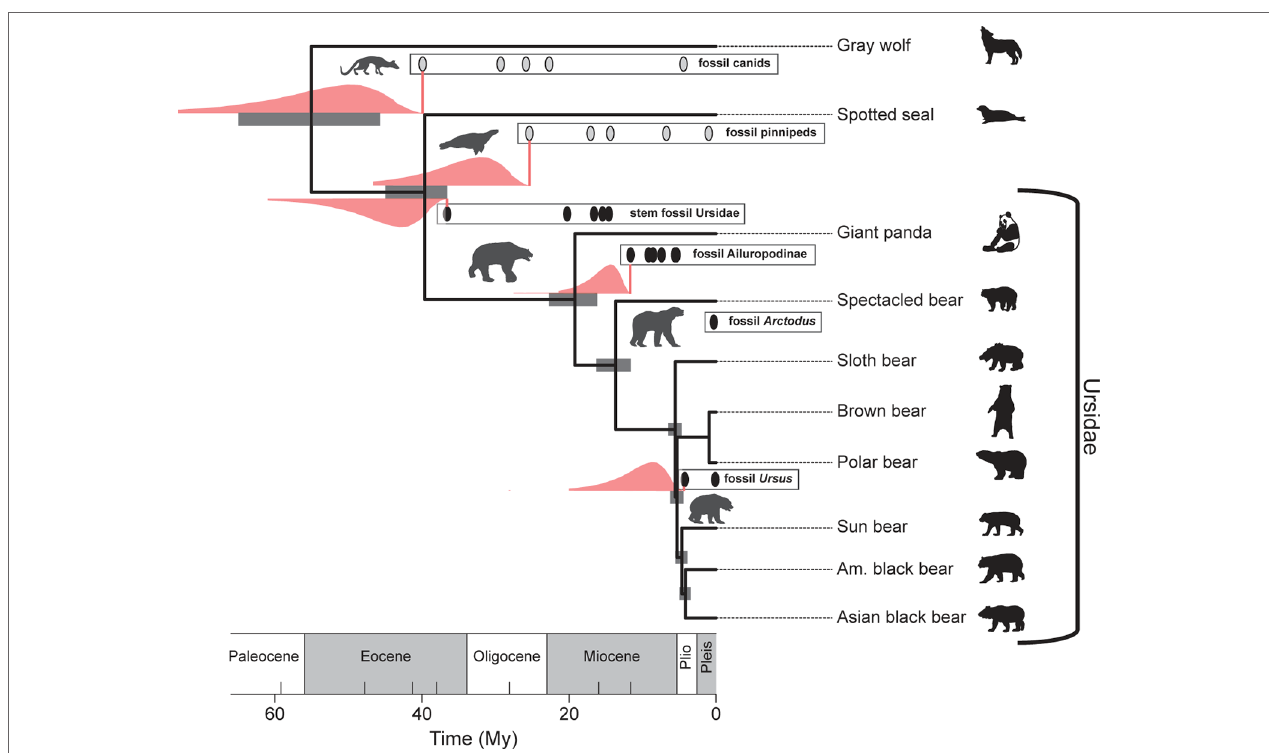
FIGURE 5 | Broad agreement in the estimated uncertainties in the divergence times of selected bear and outgroup lineages based on the FBD (fossilized birth– death) process (gray bars) (Heath et al., 2014) and those based on lognormal-like likelihood analysis of the fossil records depicted (pink distributions; see also Figure 4). Pink vertical lines correspond to the FAD s. The pink range extensions have been added to a reproduction of Figure 4 from Heath et al. (2014).